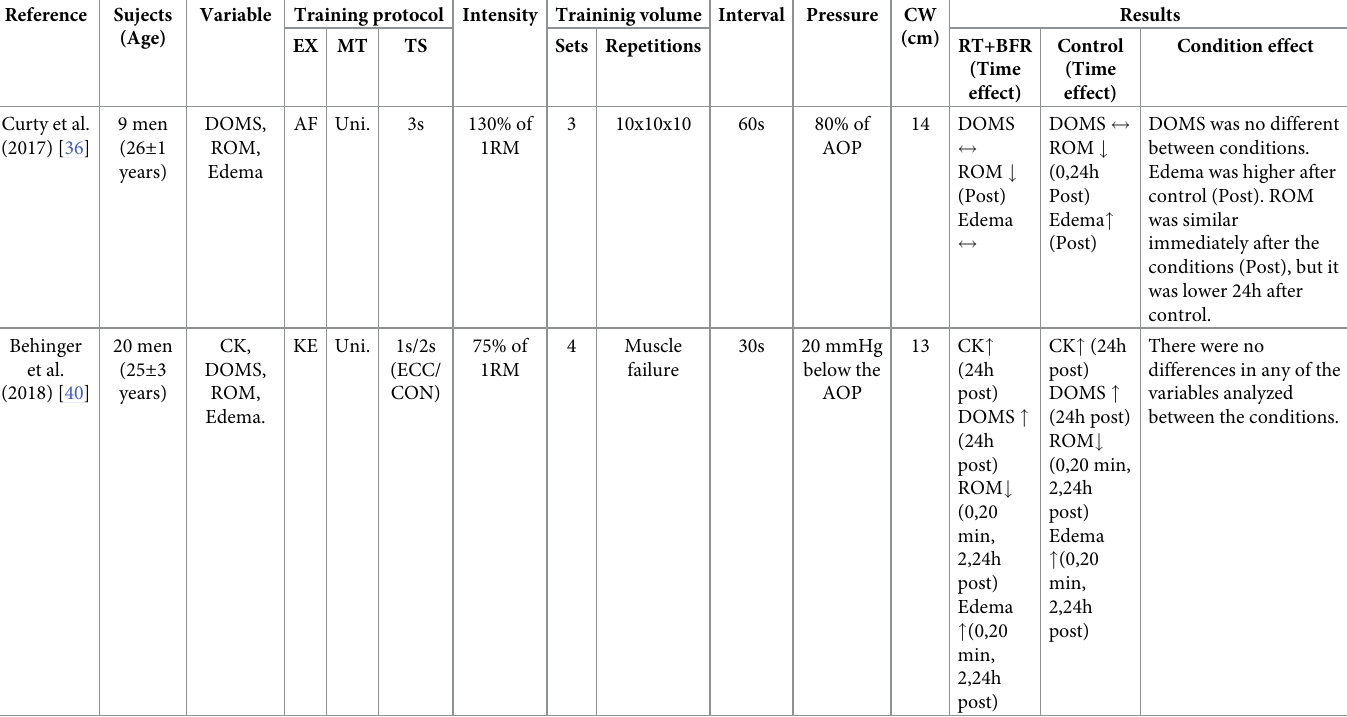
Table 3. Characteristics of studies that compared muscle damage between traditional high-load resistance exercise and high-load resistance exercise with blood flow